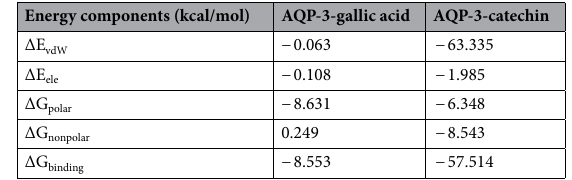
Table 5. Binding free energies from MM-PBSA in kcal/mol for AQP-3-ligands